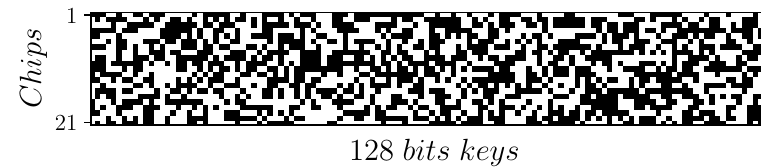
Figure 5. Graphical representation of 128-bits PUF keys over the 21 chip